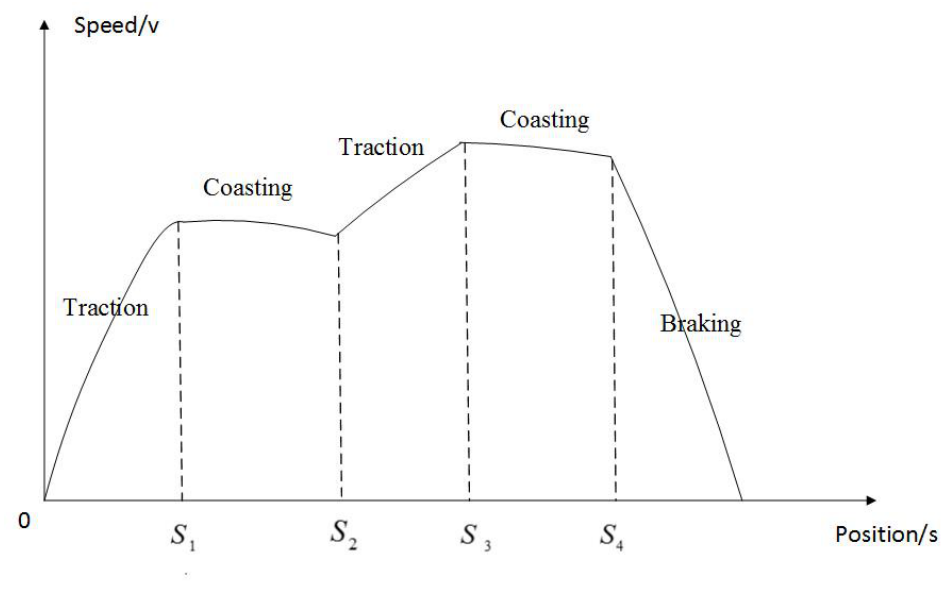
Figure 3. Optimal driving strategy for interstations.